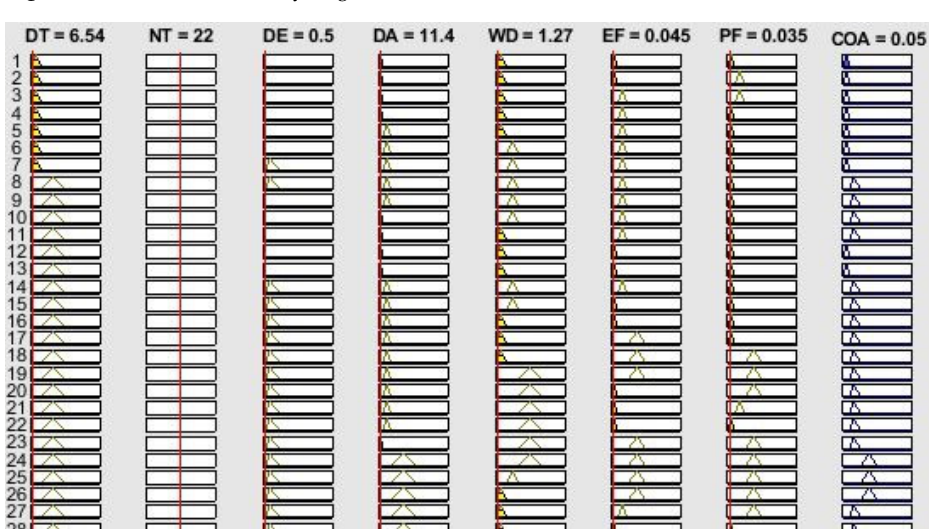
Figure 6. Rules Used in Fuzzy Logic.